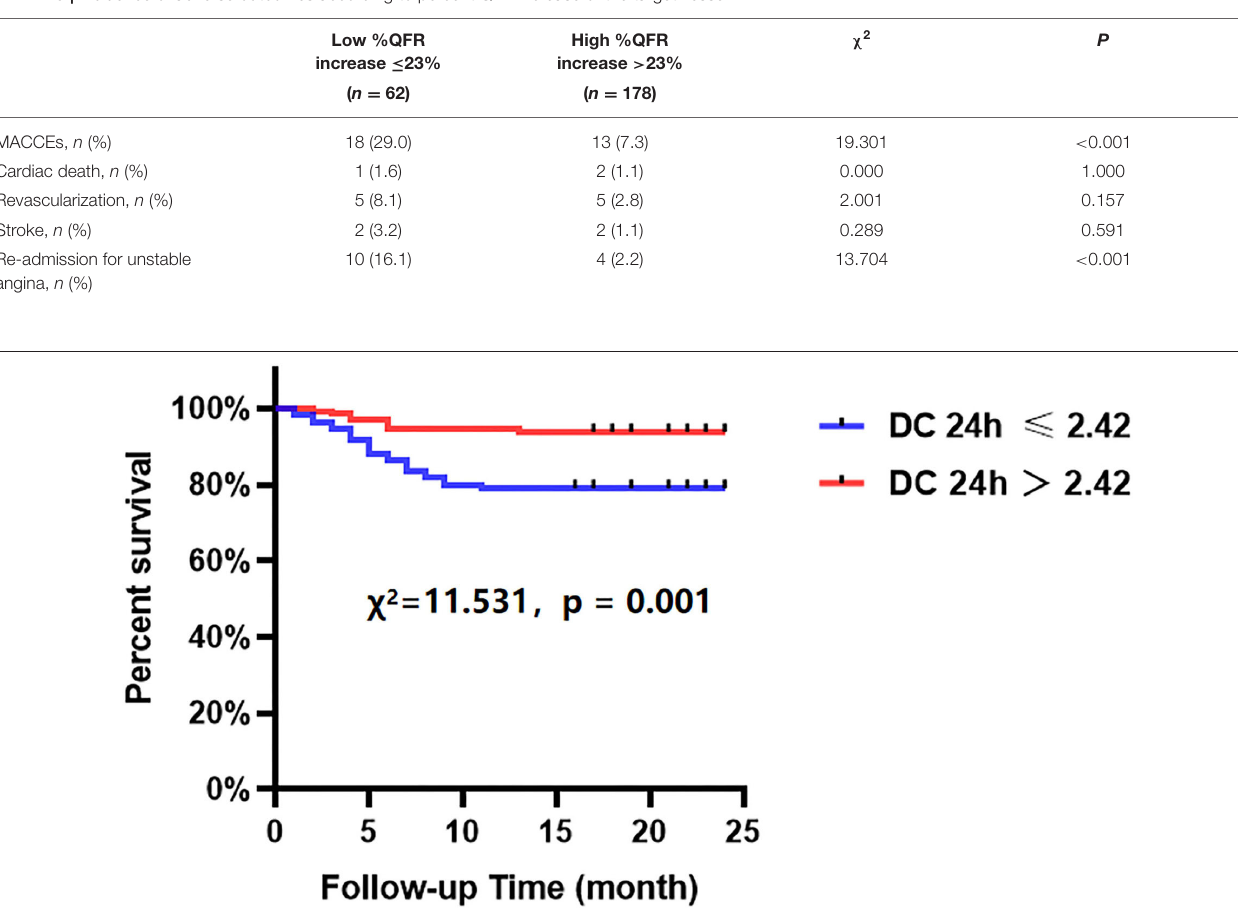
TABLE 6 | Incidence of adverse outcomes according to percent QFR increase of the target vessel.